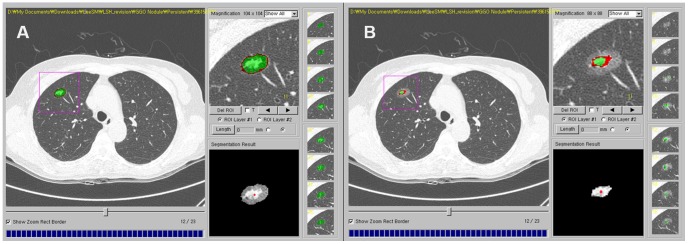
Transverse thin-section CT image showing manual segmentation of a part-solid nodule (PSN).Segmentation of the PSN was manually conducted using an in-house software program and texture features of the nodules were automatically extracted and calculated by the program. One radiologist segmented the outer boundary of the whole PSN (A) and inner solid portion boundary (B).